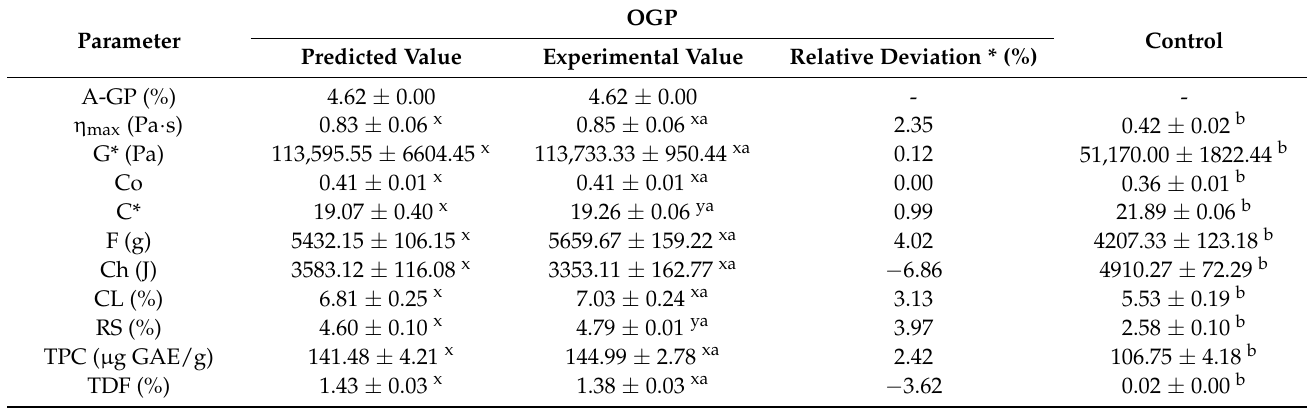
Table 2. Confirmation of the optimized parameters and control sample